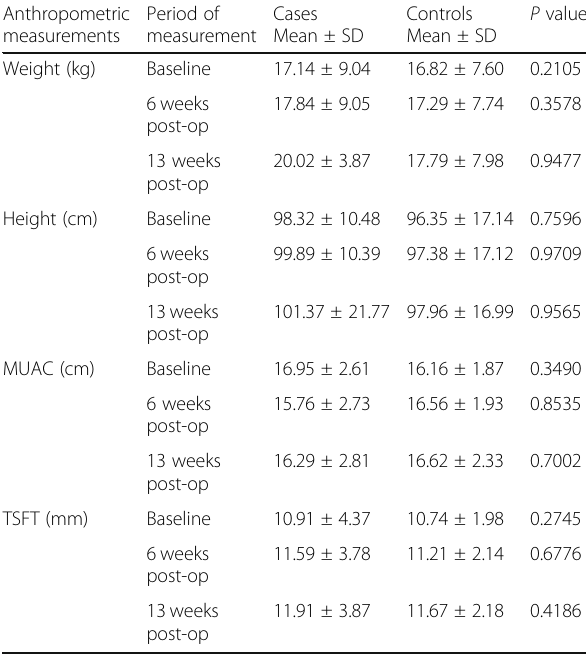
Table 2 Comparison between anthropometric measurements of cases and